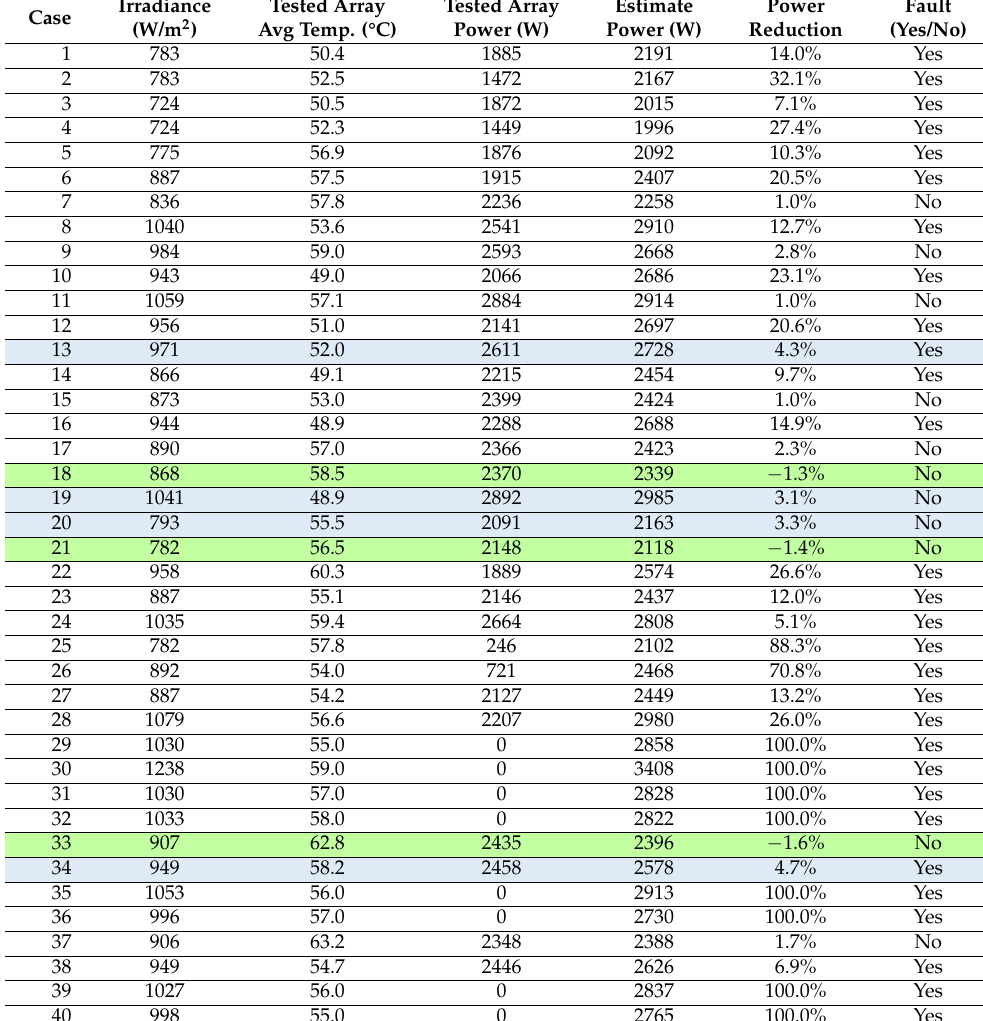
Table 7. Electrical measurements for the evaluation of each suboptimal condition with the EA technique. The last column on the right indicates the output variable of this